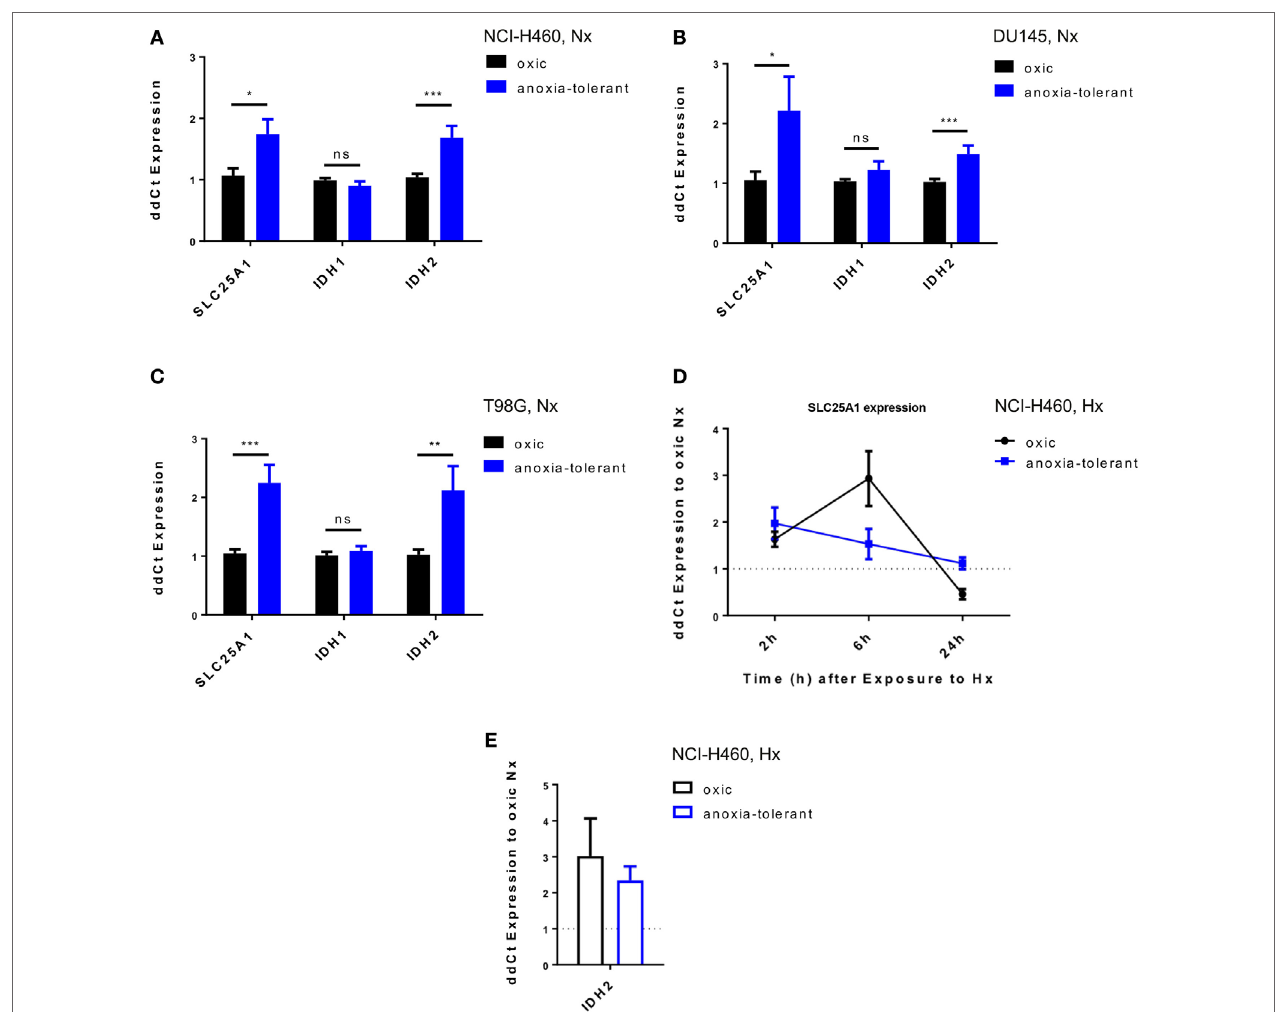
FigUre 1 | Exposure of cancer cells to acute or chronic cycling severe hypoxia leads to upregulated expression of SLC25A1 and IDH2 . Expression of SLC25A1 , isocitrate dehydrogenase 1 ( IDH1 ; cytosolic), and isocitrate dehydrogenase 2 ( IDH2 ; mitochondrial) was determined in anoxia-tolerant cancer cells generated by exposure to 16 cycles (T98G) or 25 cycles (NCI-H460, DU145) of severe hypoxia (48 h, < 0.1% O 2 ) and reoxygenation (120 h air plus 5% CO 2 referred as 20% O 2 ) and the respective oxic control cells (24) by quantitative real-time PCR analysis. Data show basal expression of SLC25A1 , IDH1 , and IDH2 in (a) NCI-H460, (B) DU145, and (c) T98G oxic and anoxia-tolerant cells under normoxic (Nx) conditions (20% O 2 ). Changes in SLC25A1 [2–24 h, (D) ] and IDH2 [24 h, (e) ] expression in oxic and anoxia-tolerant NCI-H460 cells in response to acute severe hypoxia (Hx, 0.2% O 2 ). Data were always normalized to the respective oxic control cells under basal Nx conditions. Mean values ± SEM are shown, n = 3 (* p ≤ 0.05, ** p < 0.01, and *** p ≤ 0.001; t